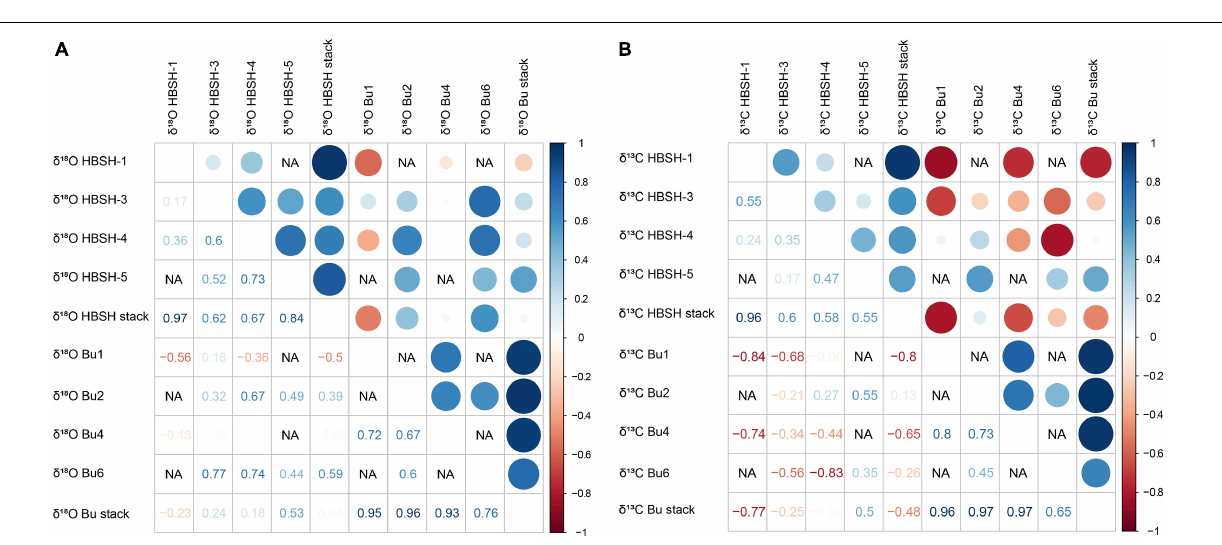
FIGURE 11 | (A) Correlation matrix of centennial means for δ 18 O of the four Bu (Fohlmeister et al., 2012) and HBSH stalagmites, as well as the two HBSH and Bu stacks. (B) As for (A) for the δ 13 C values. The size of the circles increases with increasing positive/negative